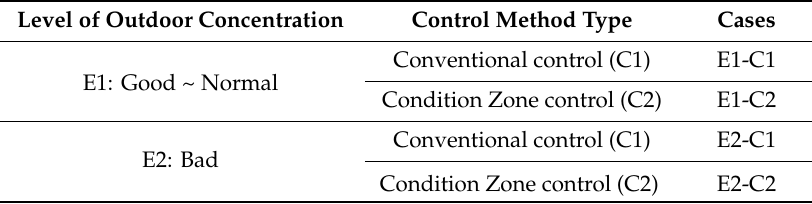
Table 7. Simulation